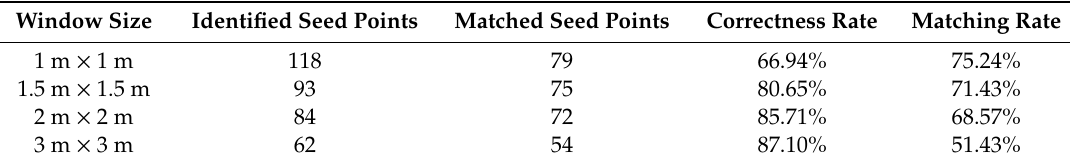
Table 3. Seed point matching